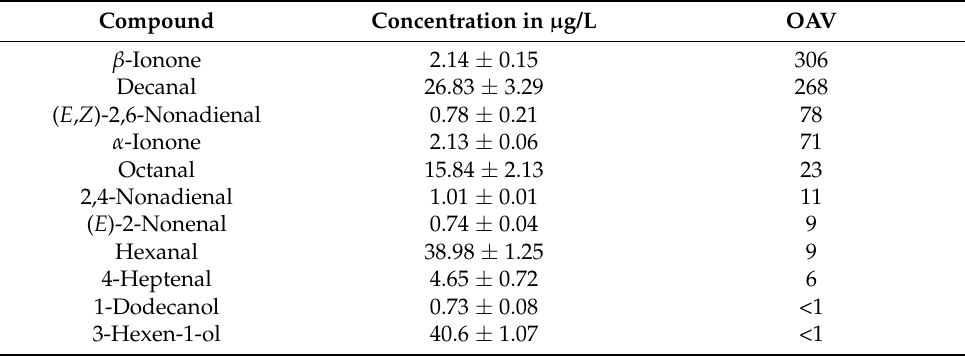
Table A9. Results of semi-quantification and calculated OAVs for sample